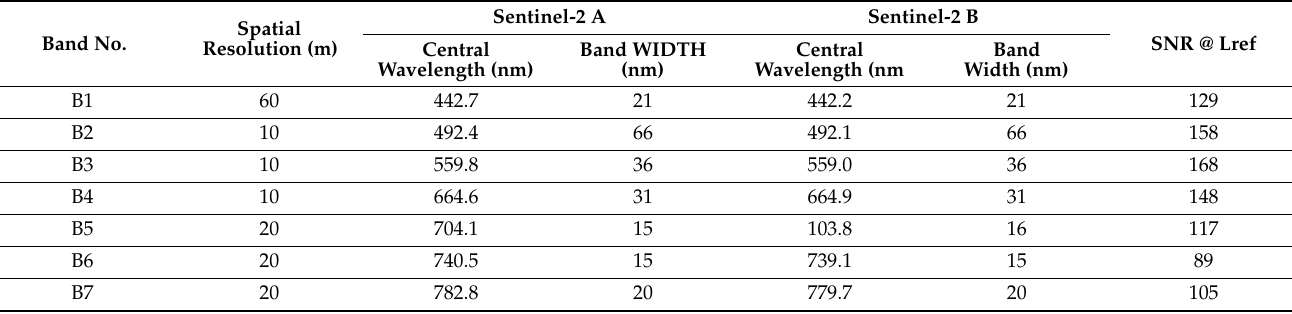
Table 1. Sentinel-2 band